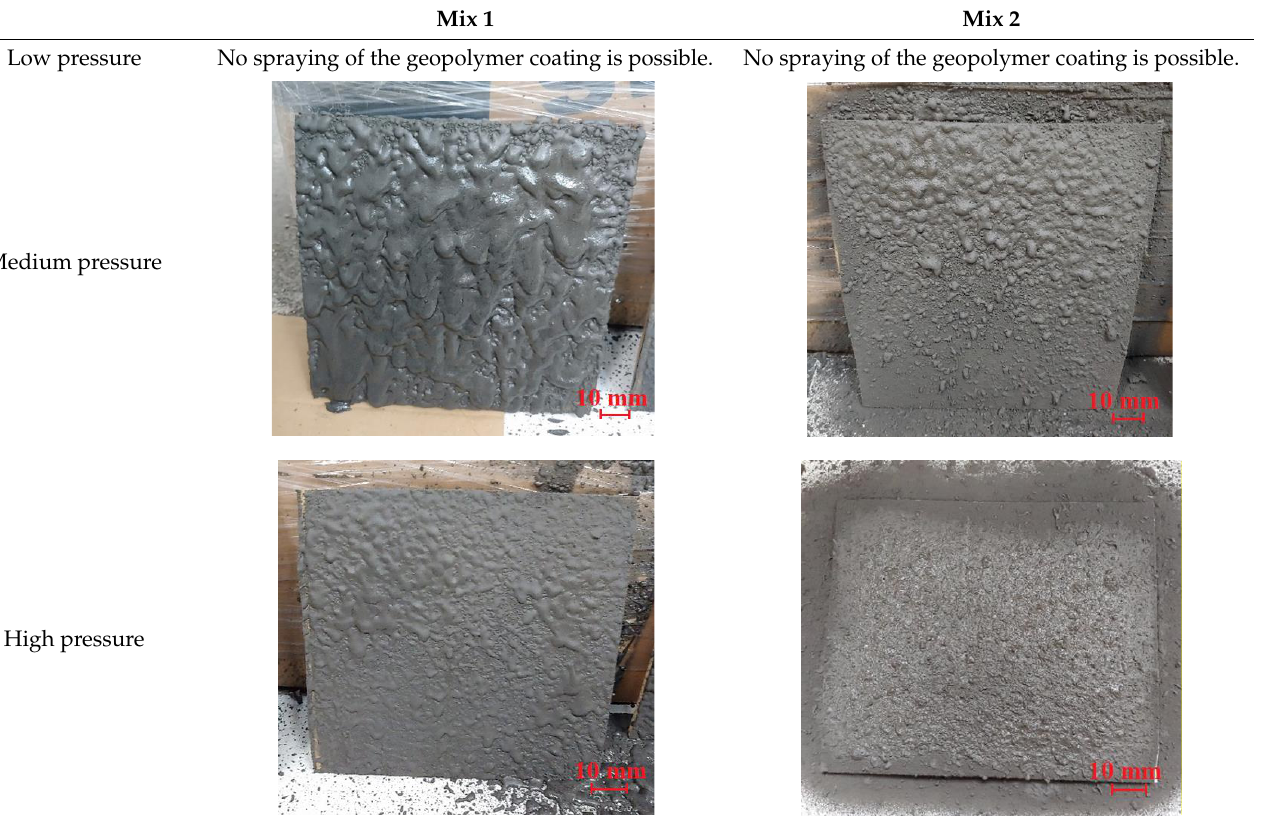
Table 6. Working pressure range of the 6 × 10 − 3 m spray nozzle for geopolymer materials. Mix 1 Mix 2 Low pressure No spraying of the geopolymer coating is possible. No spraying of the geopolymer coating is possible.